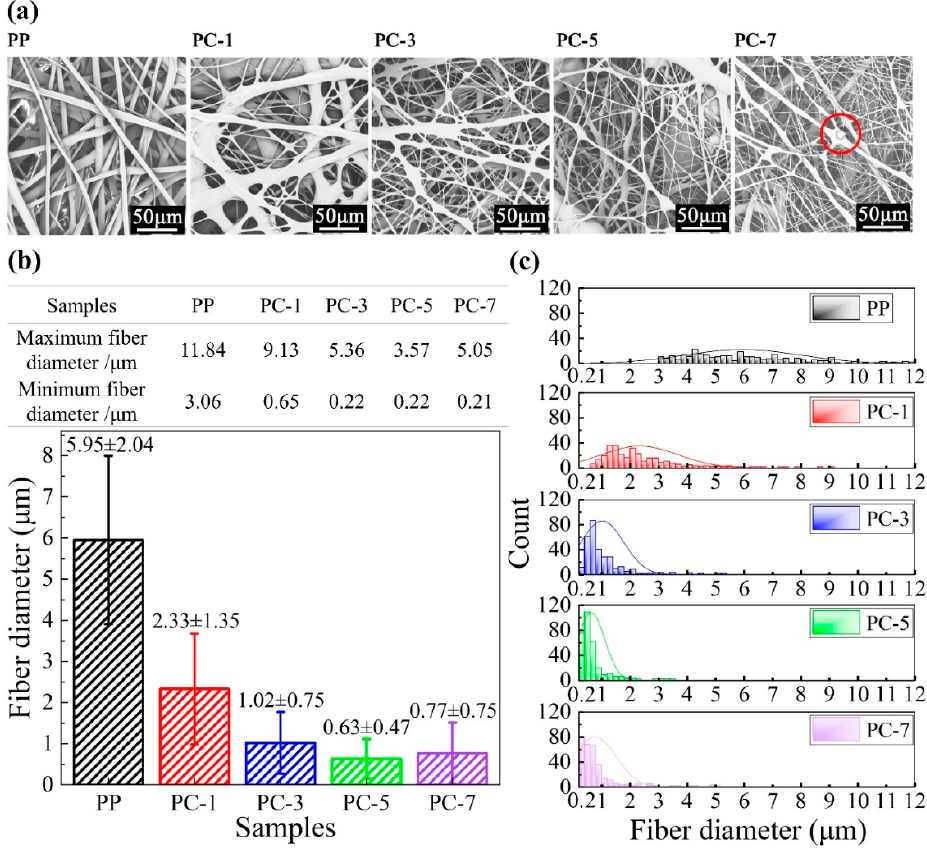
Figure 6. PP and PC-5 ( a ) fiber surface and ( b ) SEM original image at 4500× magnification, as well as the pictures after they were denoised by Photoshop. Figure 7. The pull-out process of PC to PP: PP and PC under the action of ( a ) high temperature screw shear force and ( b ) hot air.